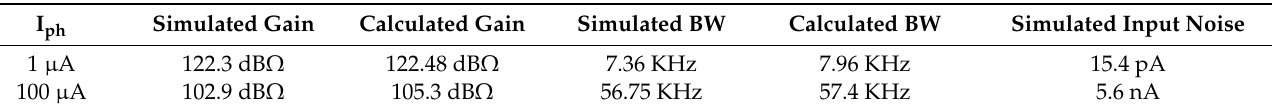
Table 2. Calculated and simulated results for the gain and bandwidth.